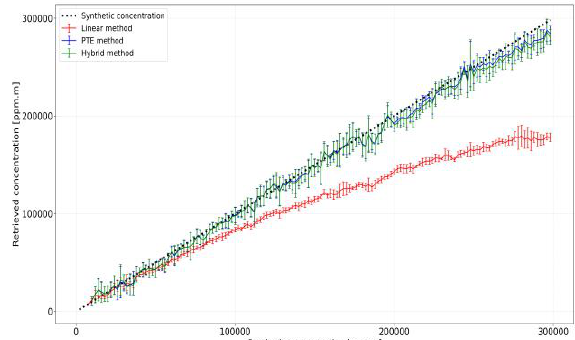
Figure 9 . Retrieved concentrations for the three methods according to the synthetic plume concentration in semi- synthetic case.